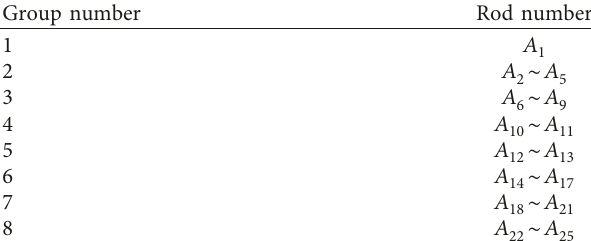
Table 5: 25bar space truss classification.